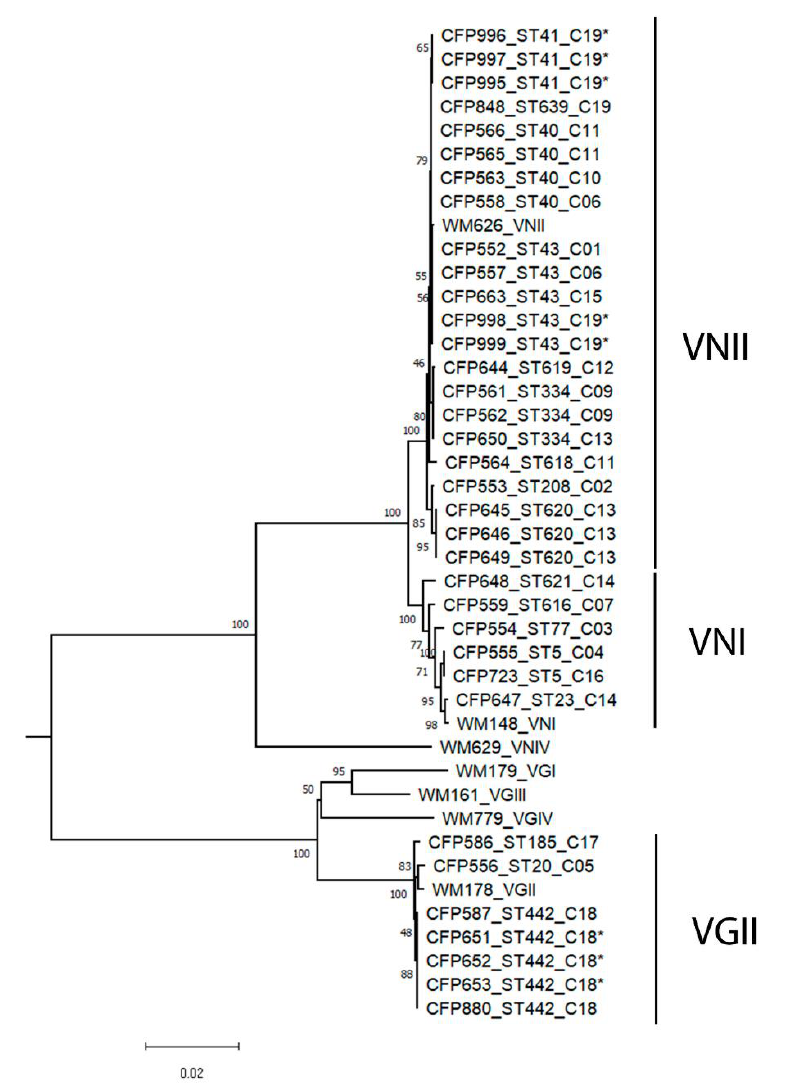
Figure 2. Unrooted neighbor-joining tree inferred from the combined MLST sequences of CAP59 , GPD1 , LAC1 , SOD1 , URA5 , and PLB1 genes and the IGS1 region of the 36 strains investigated in this study, and the 7 standard strains. Numbers above the branches are bootstrap values obtained from 1000 pseudoreplicates. Samples are identified with the Culture Collection number (CFP), followed by the subtype (ST) and the number of the cat (C). (*) Environmental isolates.